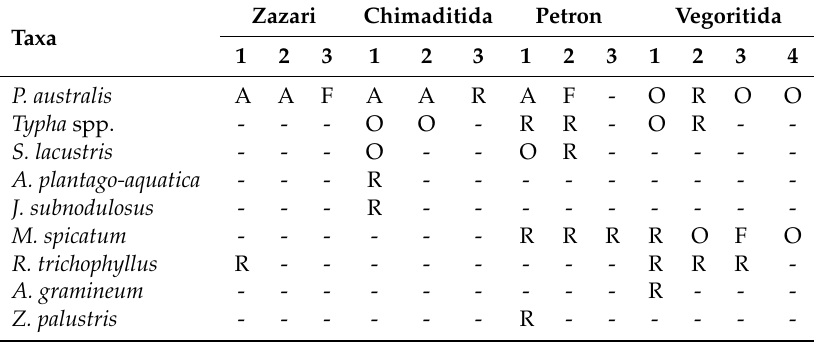
Table 4. Abundance per depth-zone (1: 0–1 m; 2: 1–2 m; 3: 2–4 m; 4: 4–8 m) of the selected macrophytic indicator taxa. D—Dominant > 75%; A—Abundant 25–75%; F—Frequent 10–25%; O—Occasional 1–10%; R—Rare < 1%.